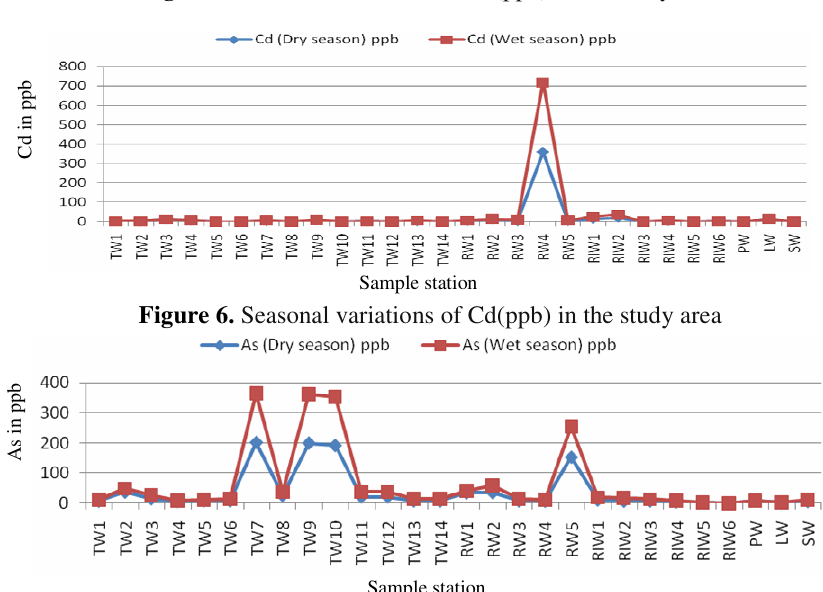
Figure 7. Seasonal variations of As (ppb) in the study